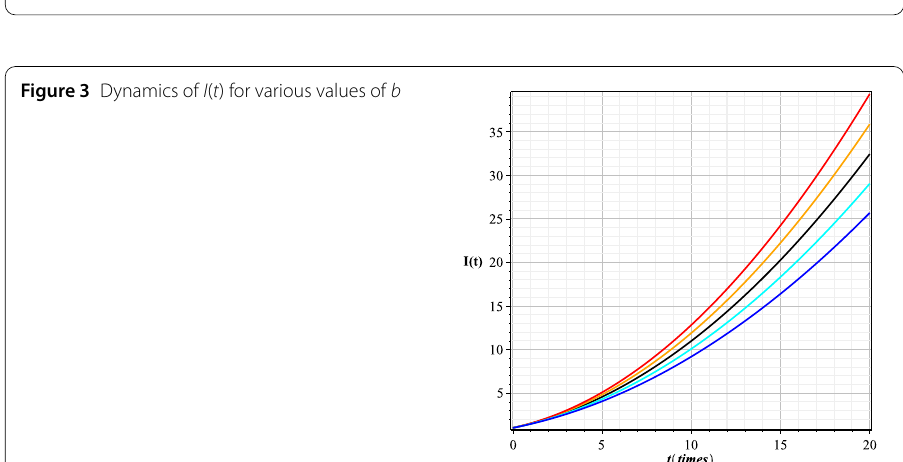
Figure 3 Dynamics of I ( t ) for various values of b